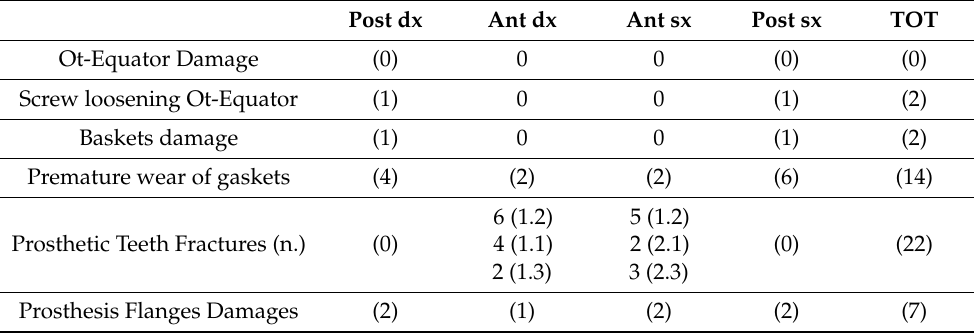
Table 3. Prosthetic complications in overdentures during the 72 months of observation. Right rear areas (Post dx), Left rear (Post sx), Right front (Ant dx), Left front (Ant